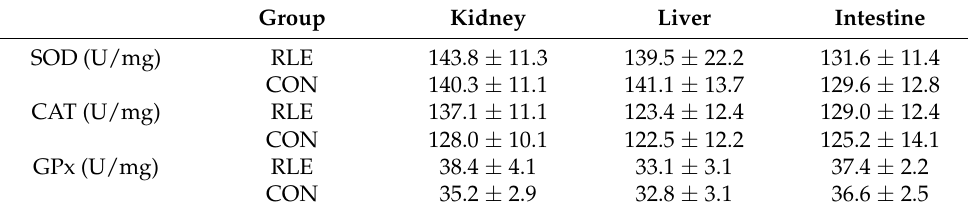
Table 7. Effects of red orange and lemon extract (RLE) on SOD, CAT, and GPx activities in renal, liver, and intestine of experimental groups at the end of treatment.